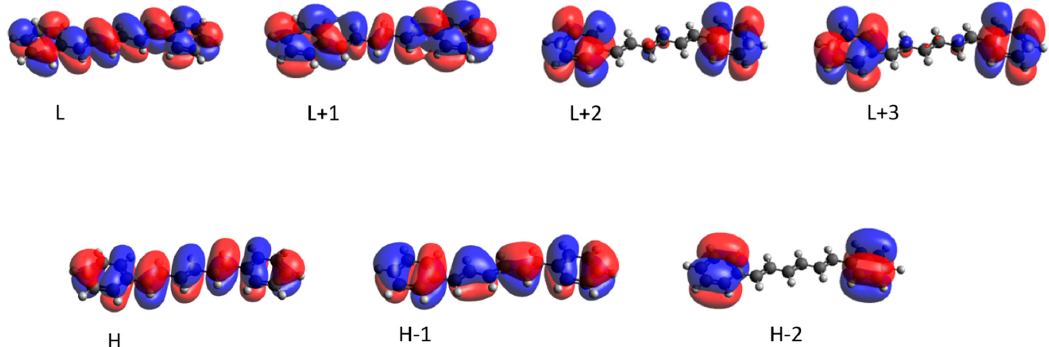
Figure A6. Frontier orbitals of DPH at the CAMB3LYP/cc-pVDZ level of theory. H and L denote the highest occupied and lowest unoccupied molecular orbital, highest occupied and lowest unoccupied molecular orbital, respectively.